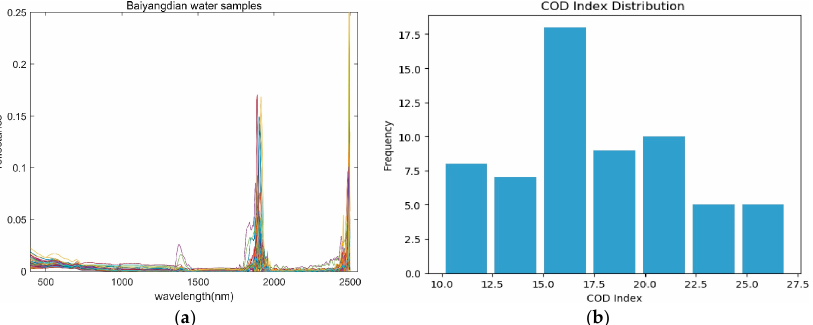
Figure 2. ( a ) Hyperspectral plot for Baiyangdian area; and ( b ) chemical oxygen demand (COD) distribution based on samples from Baiyangdian area.